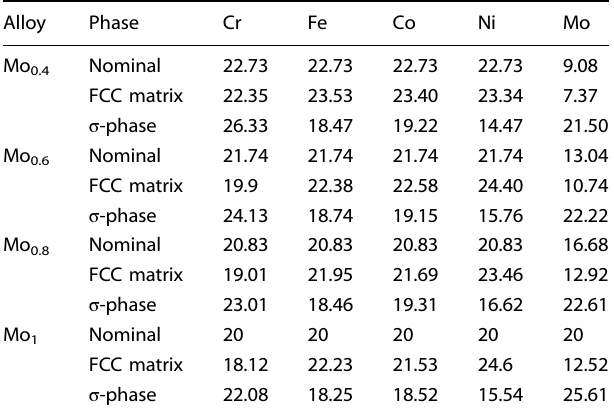
Fig. 3 Phase maps of the EBSD of CoCrFeNiMo x HEAs. Phase maps of a Mo 0 , b Mo 0.2 , c Mo 0.4 , d Mo 0.6 , e Mo 0.8 , f Mo 1 , the blue in the phase map stands for the FCC phase, the yellow stands for the σ -phase, and the green stands for unrecognized area. Table 1. Chemical compositions for each phase of CoCrFeNiMo x ( x = 0.4, 0.6, 0.8 1) HEAs (at.